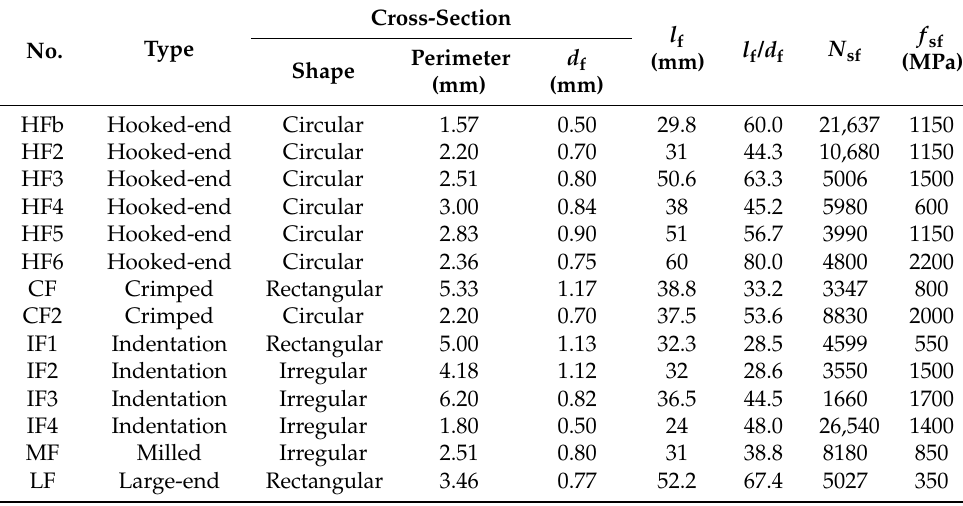
Figure 1. Different deformed steel fibers. Table 1. The characteristic parameters of deformed steel fibers.